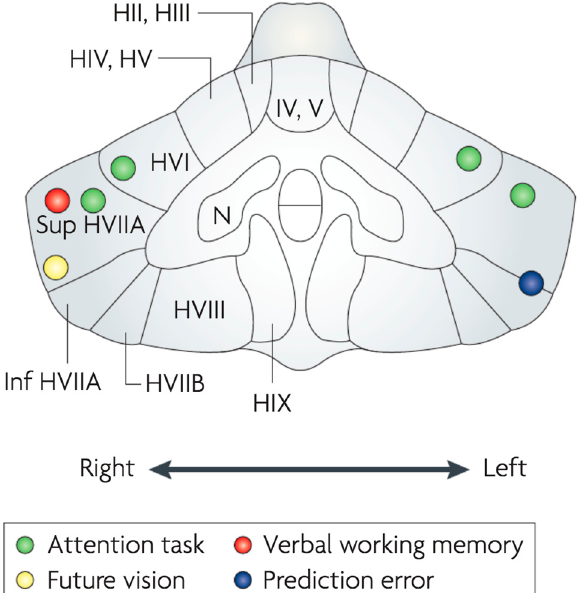
Figure 3. Mental activities controlled by schemata in the cerebellum. The figure shows a coronal section of a human cerebellum on which the sites of the observed activities are indicated by colored circles. Reprinted with permission from ref. [43]. 2008, M. Ito.